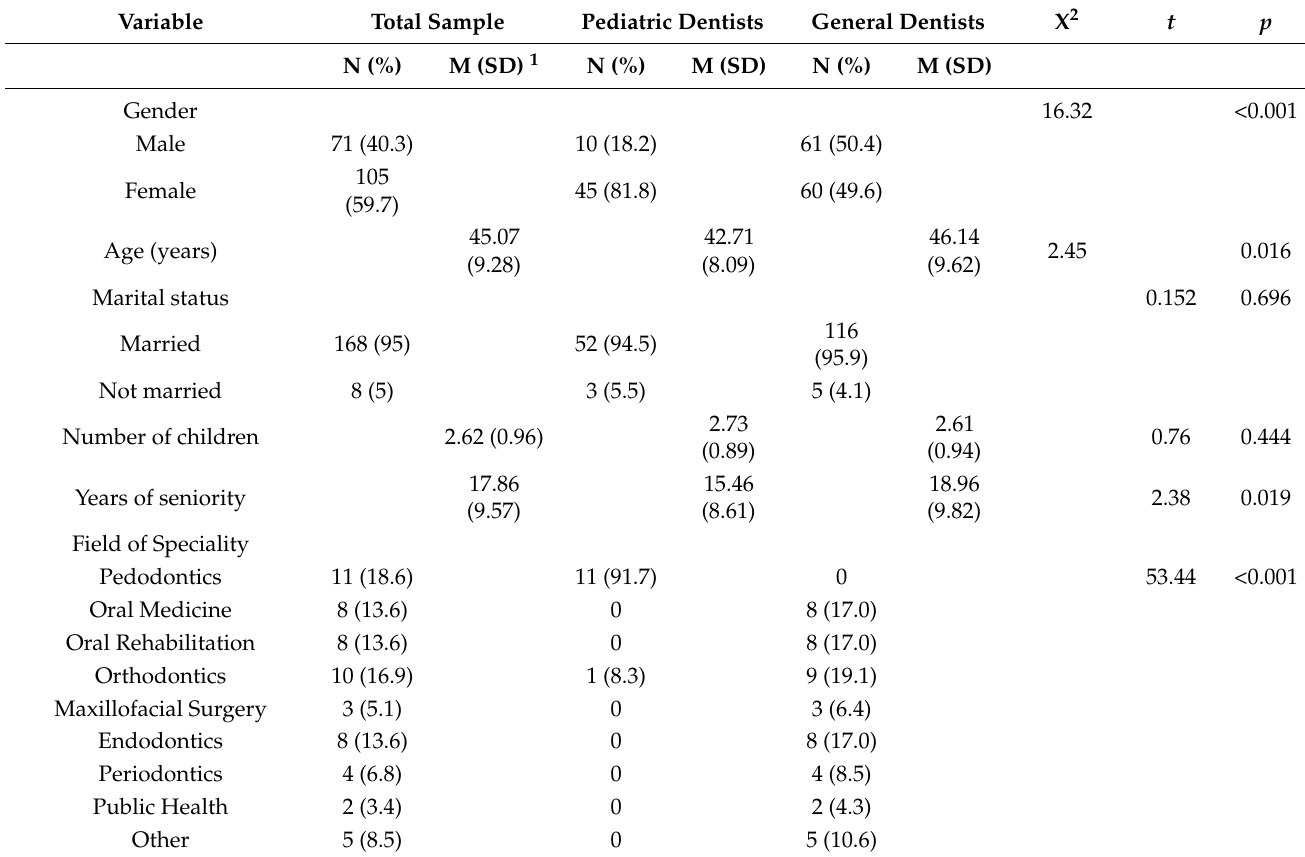
Table 1. Demographic and professional characteristics of the sample.